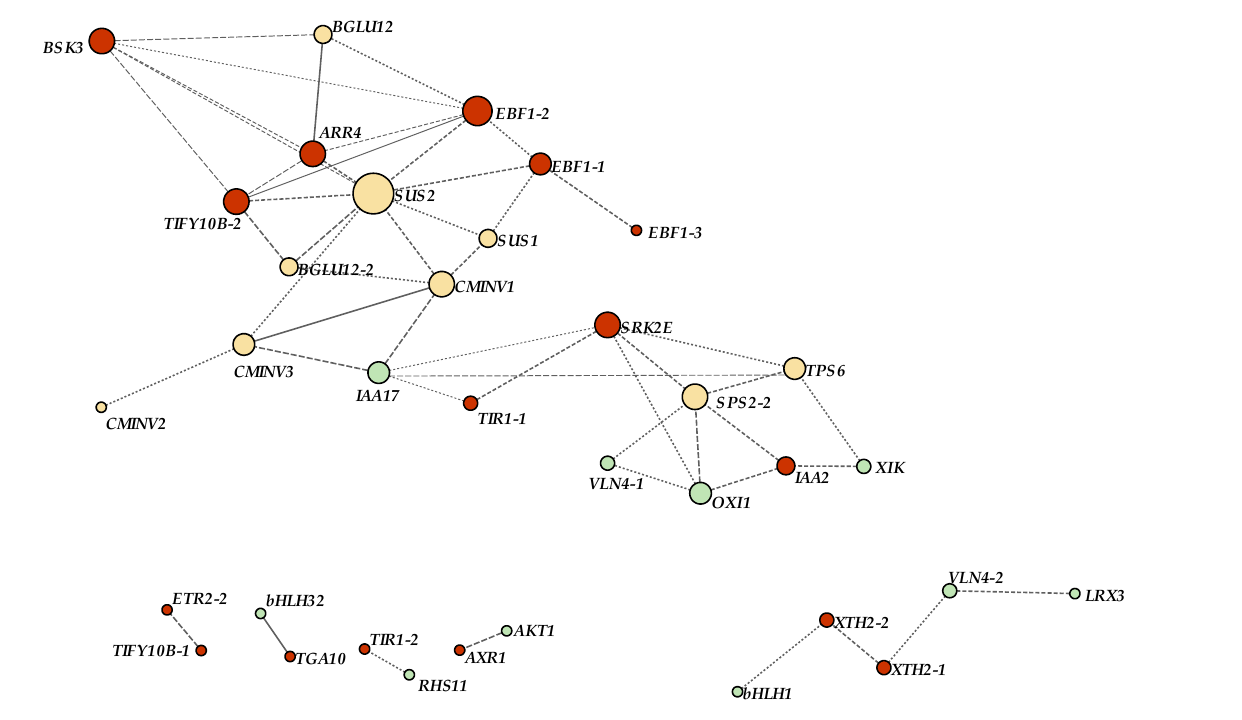
Figure 7. Screening of hub DEGs in hormone signal transduction and sugar metabolism pathway related to root hair growth and development genes in root development regulation of A. beshanzuensis . Each node indicates a gene. Yellow nodes, hub DEGs in sugar metabolism pathway; red nodes, hub DEGs in hormone signal transduction; green nodes, gene connections involved in root hair growth and development of A. beshanzuensis . Bigger nodes indicate more connections.